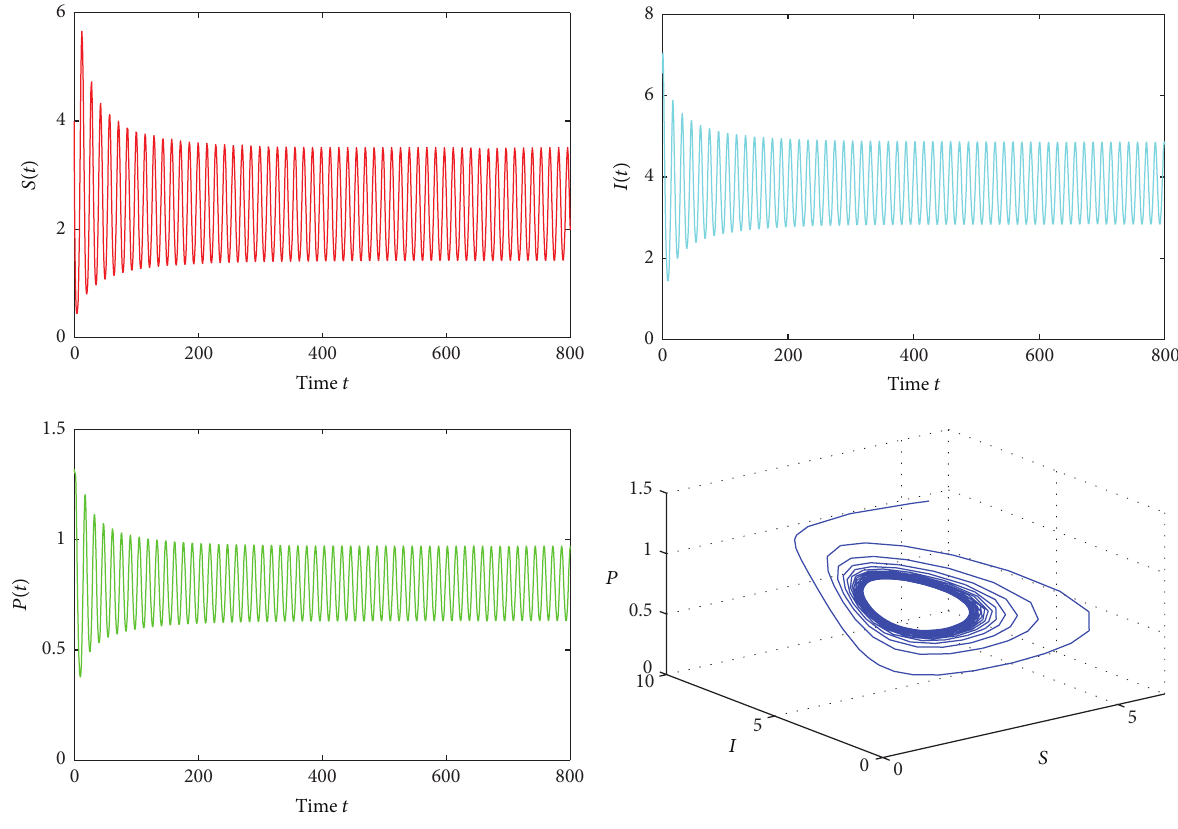
Figure 4: 𝐸 ∗ is unstable when 𝜏 2 = 2.25 > 1.8829 = 𝜏 20